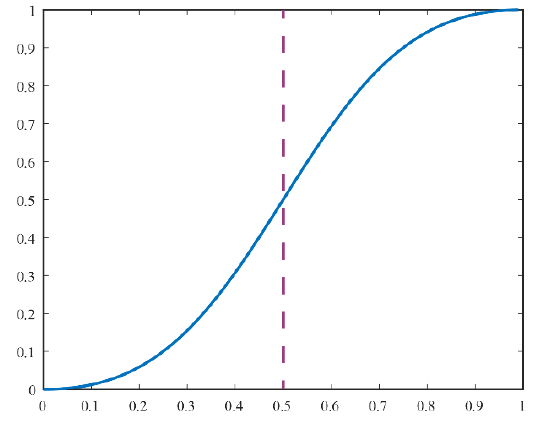
Figure 7. The function curve of Equation (30).